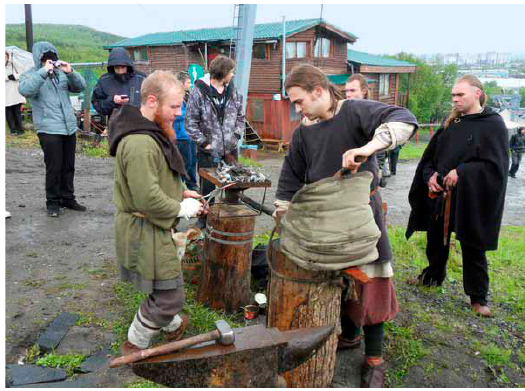
Fig 1. The blacksmith (Yuri Shachnev) in working